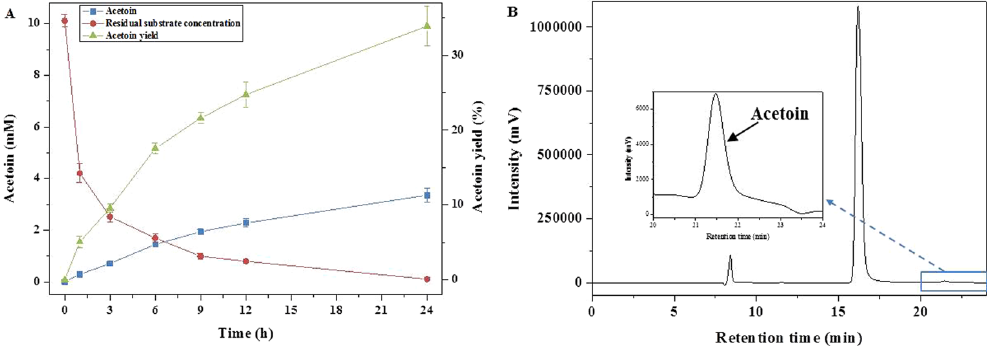
Figure 5. Production of acetoin from pyruvate under the optimal conditions. ( A ) Time course of the biocatalysis. ( B ) HPLC analysis of the products after reaction for 24 h. The reaction mixture contained 10 mM sodium pyruvate, 1 U total enzyme (coAHASL1/bsALDC 4:1), 0.5 mM ThDP, 10 μ M FAD, 10 mM MgC1 2 and 10 mM